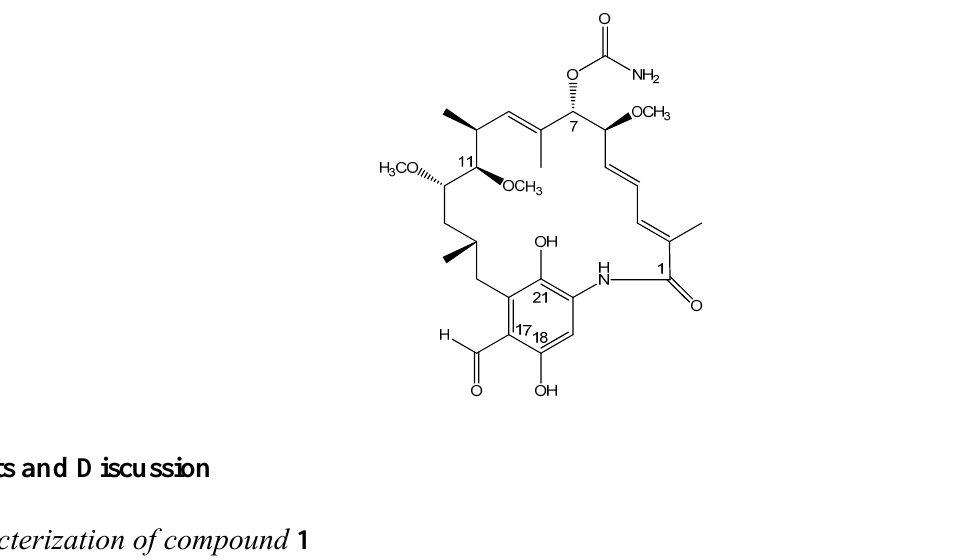
Figure 1. Structure of 11-methoxy-17-formyl-17-demethoxy-18- O -21- O -dihydrogeldanamycin ( 1 ).